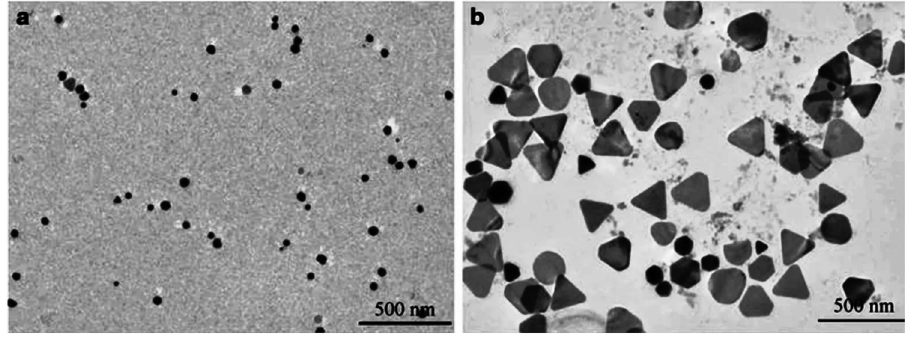
Figure 6: TEM pictures of irradiated Ag colloids samples at various gamma doses: ( a ) At 30 kGy, the majority of the resulting particles are spherical and ( b ) triangular nanoplates dominate at 100 kGy [ 130 ] . Copyright